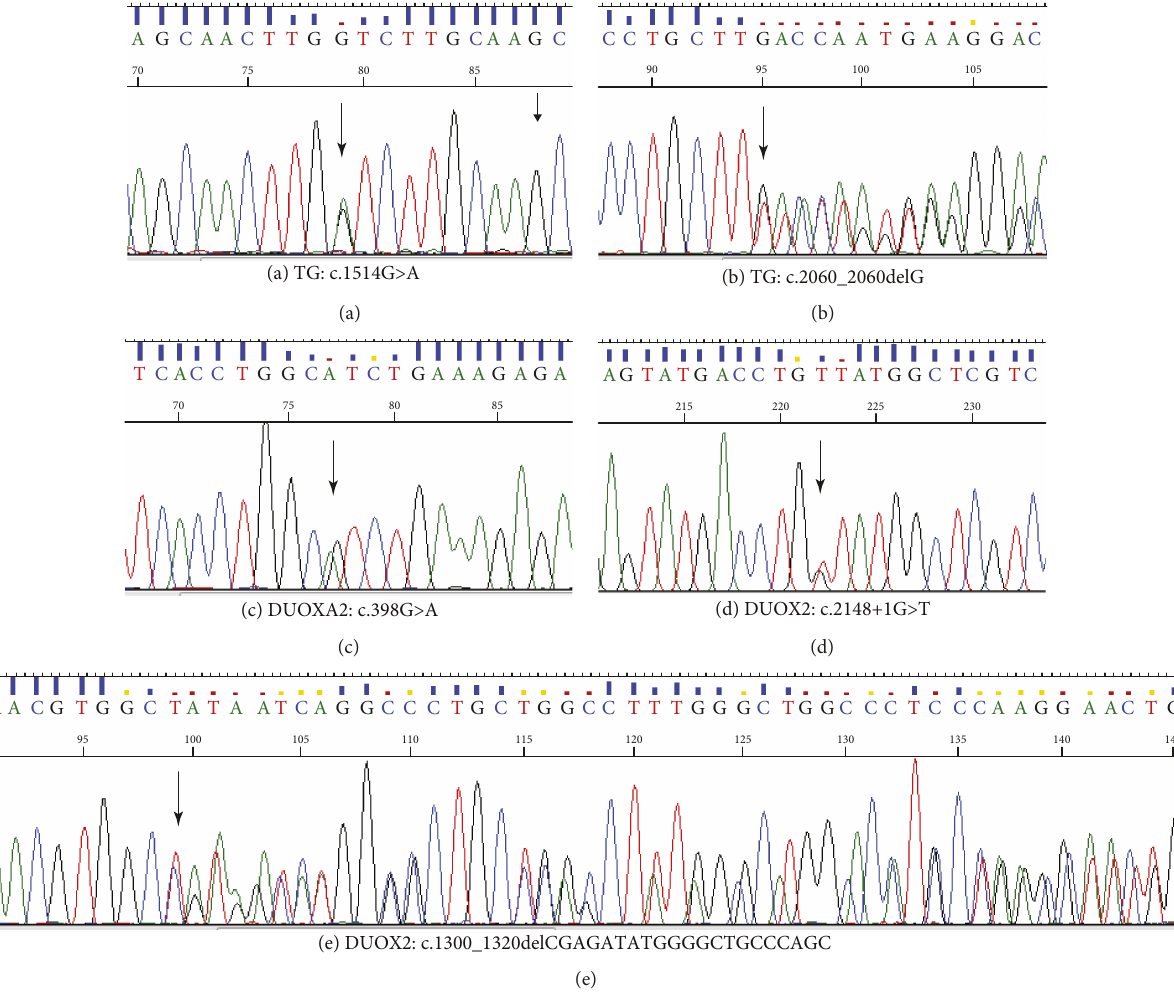
Figure 1: Sequencing chromatograms of fi ve novel variants detected in this study: (a) c.1514G > A in TG; (b) c.2060_2060delG in TG; (c) c.389G > A in DUOXA2; (d) c.2148+1G > T in DUOX2; (e) c.1300_1320delCGAGATATGGGGCTGCCCAGC in